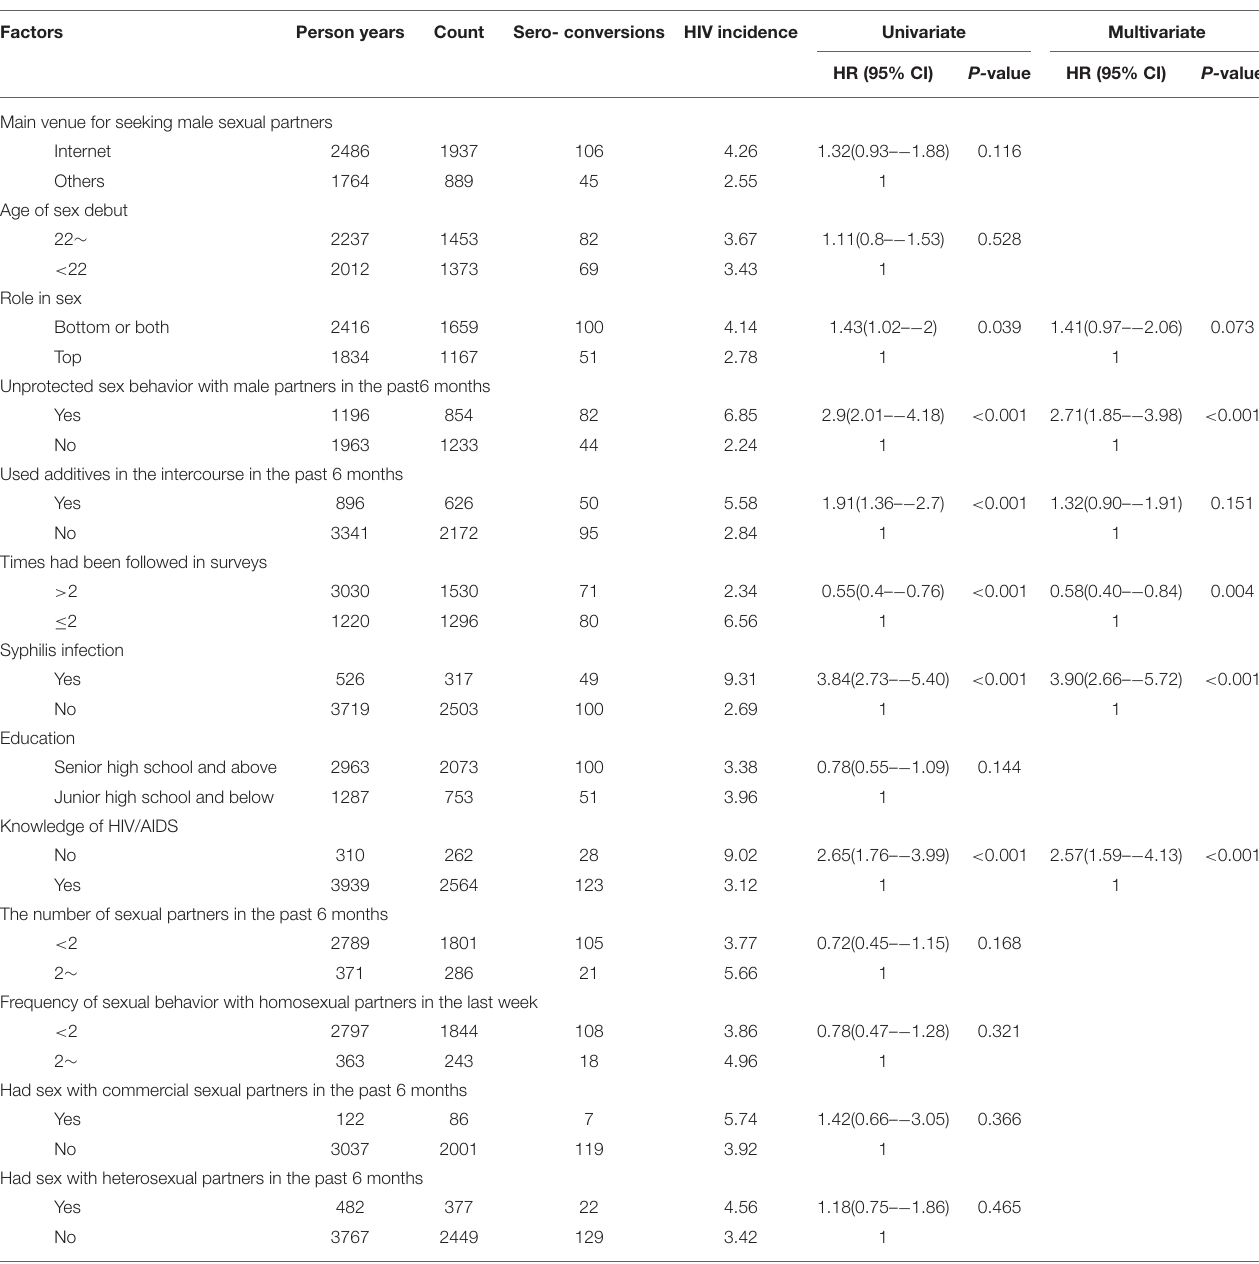
TABLE 2 | Factors associated with HIV new infection among MSM in Harbin.